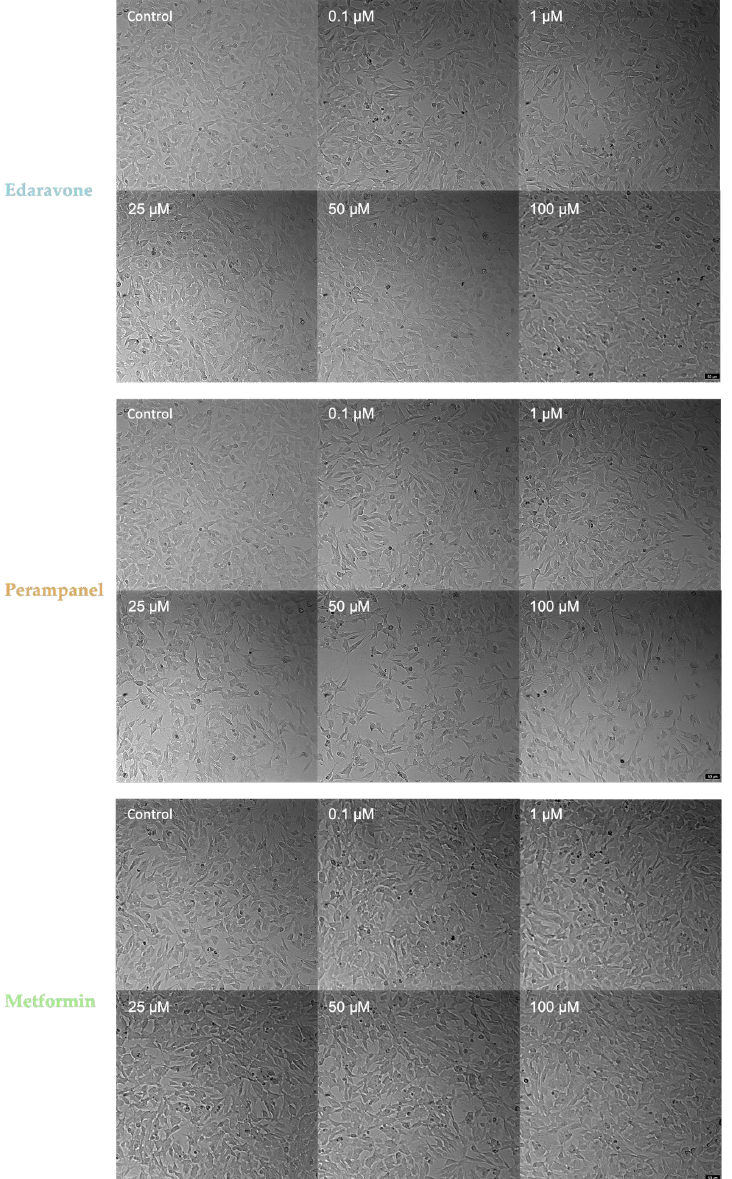
Figure 5. Microscopic representative images of SH-SY5Y control cells and SH-SY5Y cells exposed for 48 h to concentrations, ranging from 0.1 to 100 µ M, of edaravone, perampanel, and metformin. Images of cell morphology were obtained using a Leica microscope equipped with Leica LAS X imaging software v3.7.4 (Leica Microsystems, Wetzlar, Germany) from three independent experiments. Scale bar: 50 µ